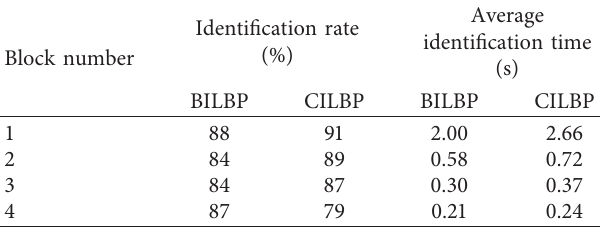
Table 2: Comparison of time consumption for the blocks BILBP and CILBP (low-frequency subimage).